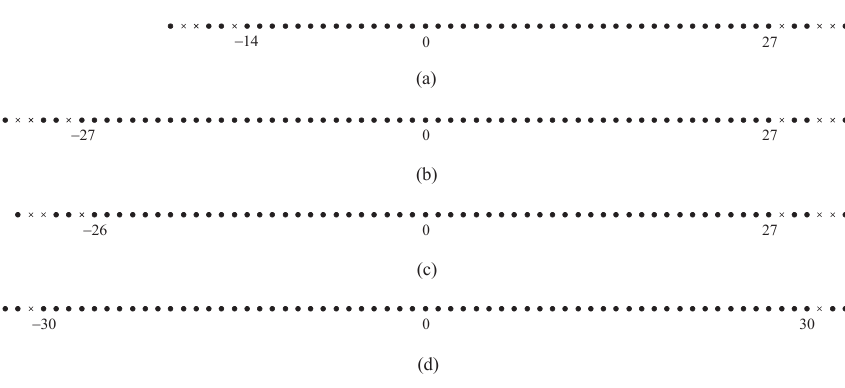
Figure 2. Two examples of the difference coarray for the CAMpS with ( M , N ) = ( 3,4 ) : ( a ) the set S cd with ( P 1 , P 2 ) = ( 2,3 ) ; ( b ) the set S dif f with ( P 1 , P 2 ) = ( 2,3 ) ; ( c ) the set S cd with ( P 1 , P 2 ) = ( 3,3 ) ; and ( d ) the set S dif f with ( P 1 , P 2 ) = ( 3,3 )